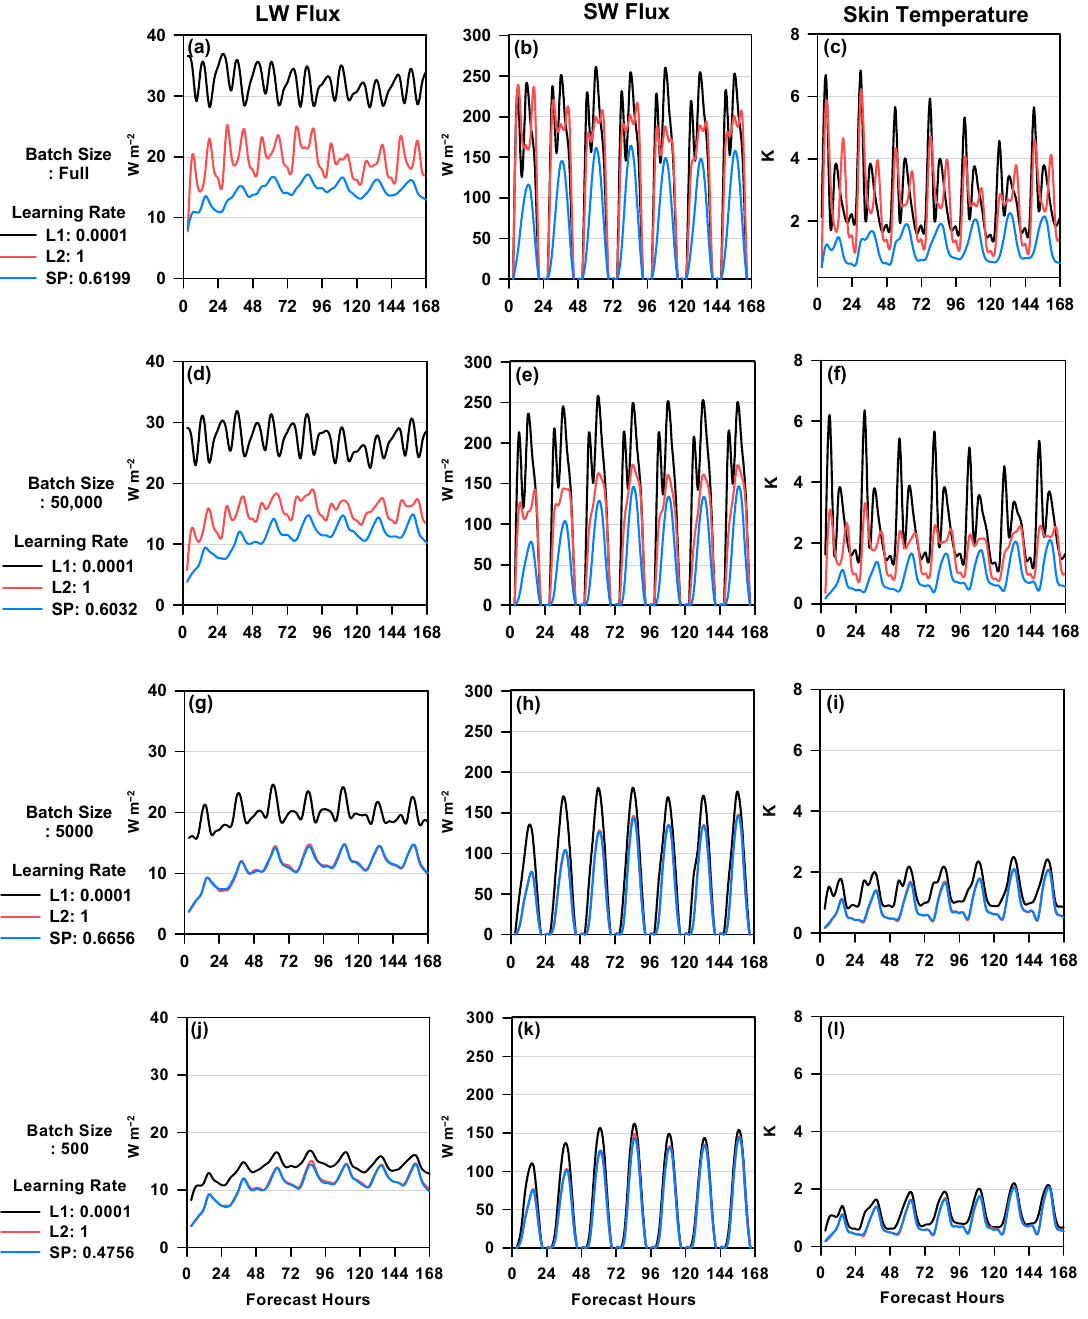
Figure 4. Time series of the root mean square errors (RMSEs) for ( a , d , g , j ) LW flux, ( b , e , h , k ) SW flux, and ( c , f , i , l ) skin temperature simulated from radiation emulators based on different batch sizes and learning rates (L1, L2, and Sherpa). Four weekly cases and the entire spatial domain were used for calculations.